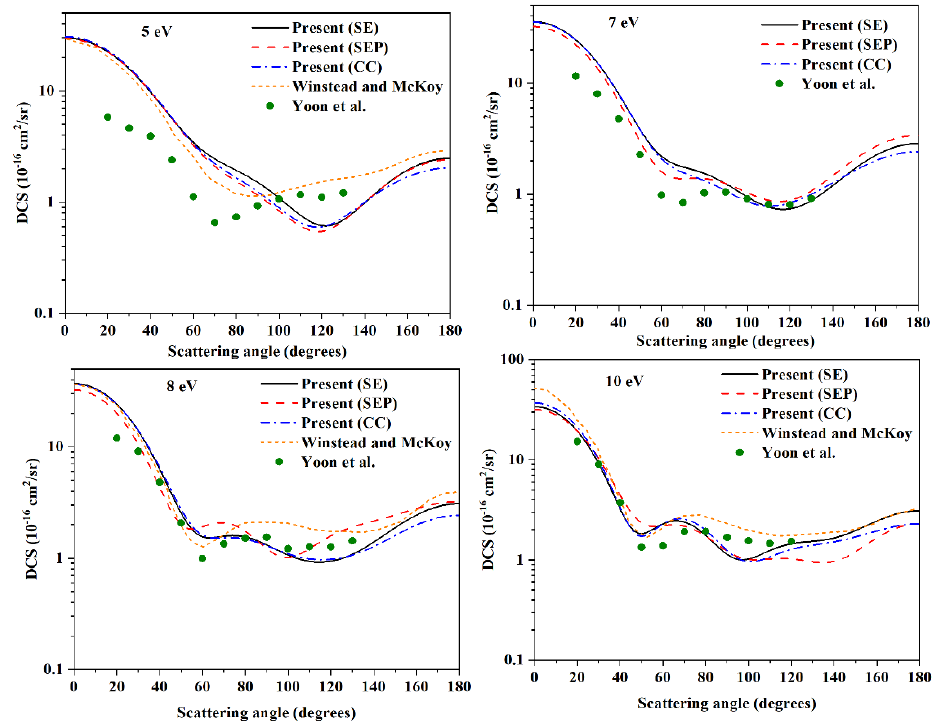
Figure 4. Elastic DCS for the electron scattering of c -C 4 F 8 system for the energies of 1.5, 3, 5, 7, 8, and 10 eV. and 10 eV.